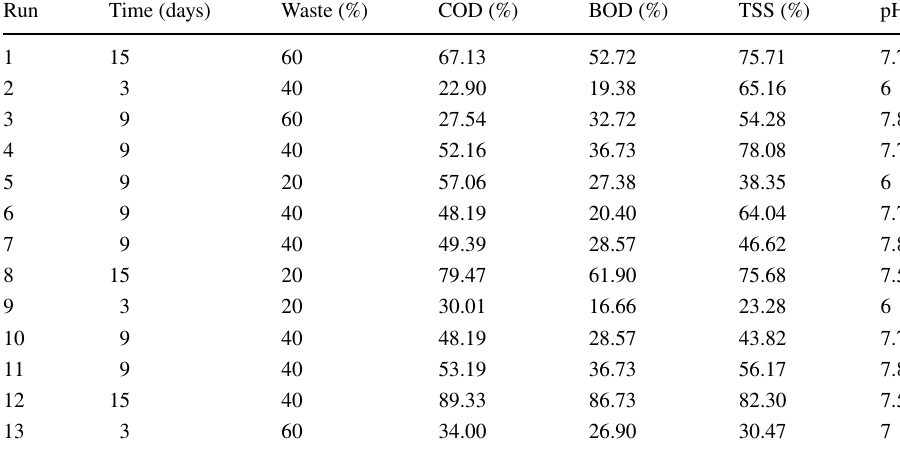
Table 1 Treatment variable and water quality decrease